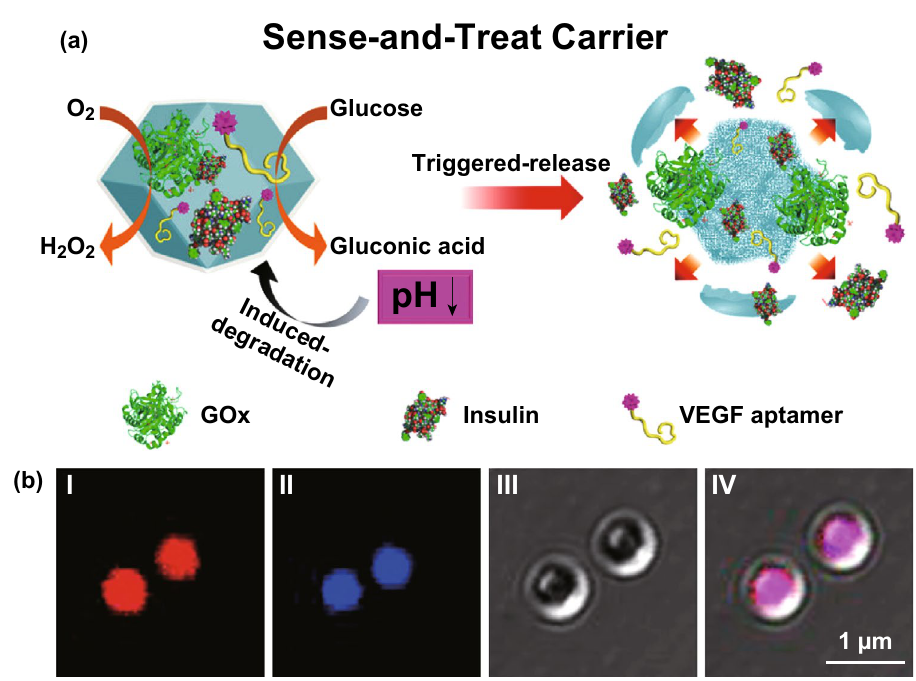
Fig. 13 a Mechanism of glucose-driven release of VEGF aptamer from ZIF-8 caused by degradation of MOFs under local acidified conditions created by GOx-catalyzed aerobic oxidation of glucose to gluconic acid. b Confocal microscopy images of ZIF-8 loaded with Cy3-modified VEGF aptamer (I) and coumarin-functionalized GOx@ZIF-8 (II), and the bright field and merged image of the loaded MOF (III and IV, respec- tively). Reproduced with permission from Ref. [149]. Copyright 2018, American Chemical